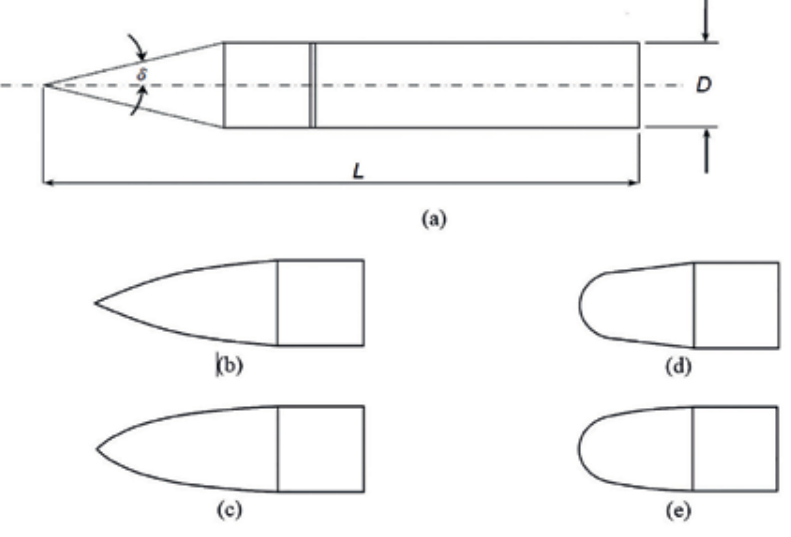
Figure 5. Aerodynamic model conceptions used in the experimental tests in wind tunnel: (a) cone–